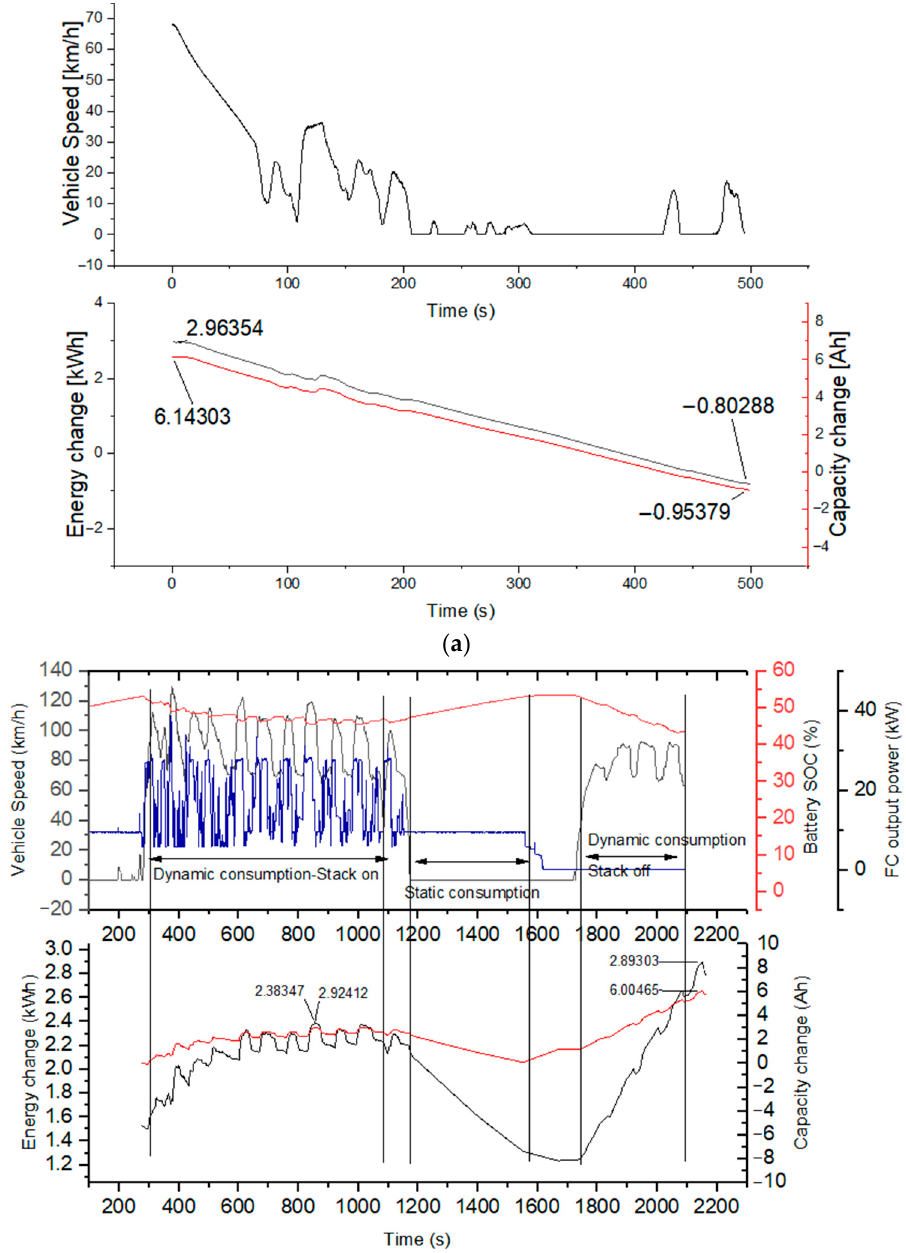
Figure 14. Comparison of adjusting SOC: ( a ) FCV A and ( b ) FCV B.